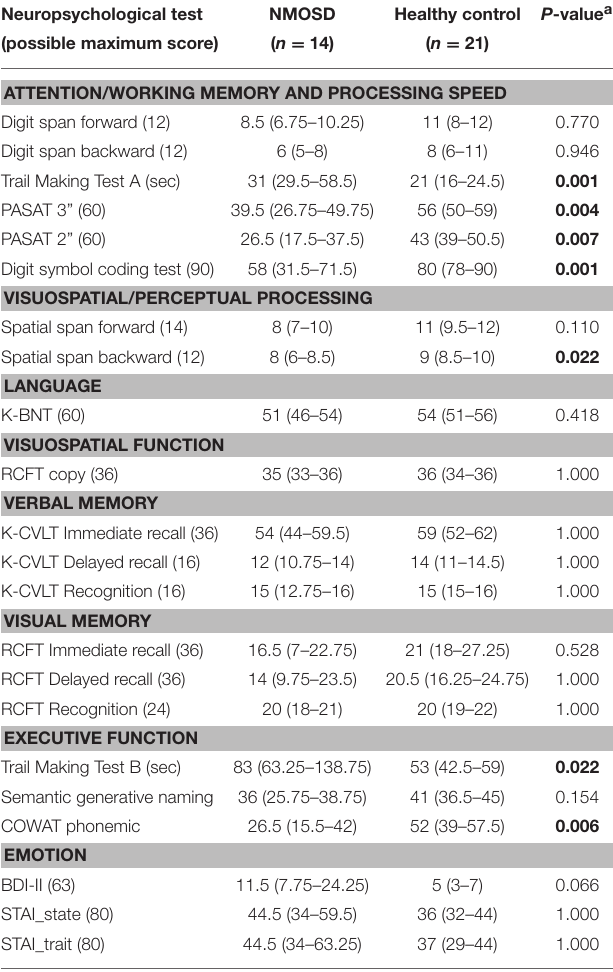
TABLE 2 | Neuropsychological test results from patients with NMOSD and healthy control group.